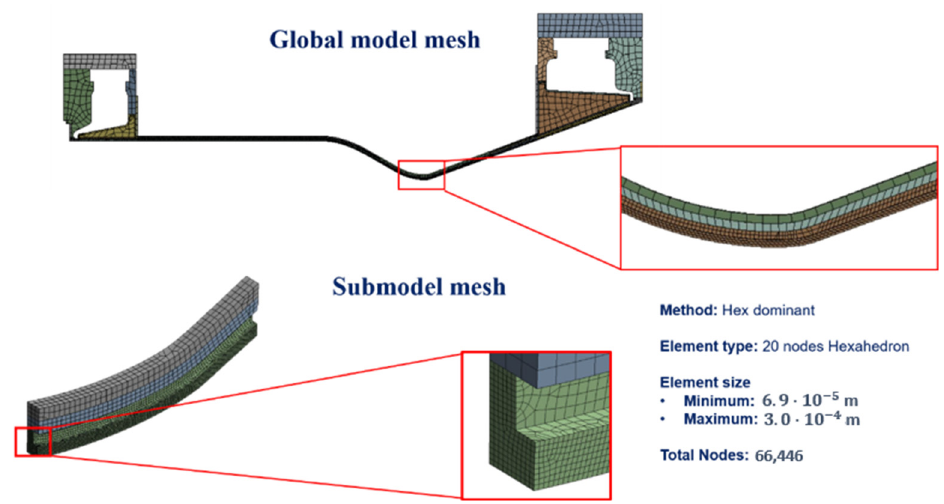
Figure 7. Adopted FEM mesh adopted, as obtained from convergence analysis. Table 9. Plastic strains, creep strains, and temperature values at the end of the hot phase. Number of Elements in the Ligament Thickness